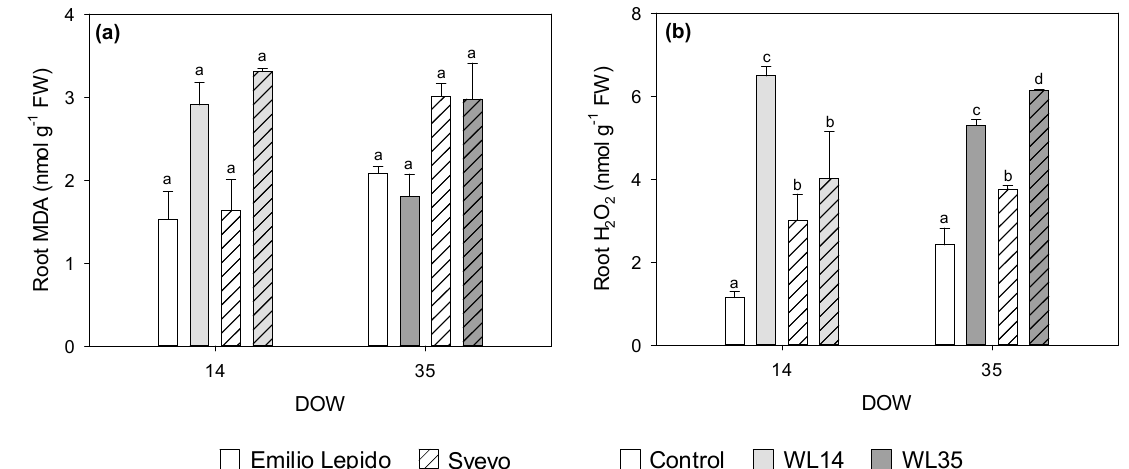
Figure 5. ( a ) Malondialdehyde (MDA) and ( b ) hydrogen peroxide (H 2 O 2 ) content in the roots of the durum wheat cultivars Emilio Lepido (solid) and Svevo (pattern) subjected to 0 (i.e., control; white), 14 (i.e., WL14; light gray), or 35 (i.e., WL35; dark gray) days of waterlogging (DOW). Data are mean ± standard deviation. FW: fresh weight. For each waterlogging duration, according to Tukey’s post hoc test ( p ≤ 0.05), different letters indicate significant differences among means ( p ≤ 0.05).